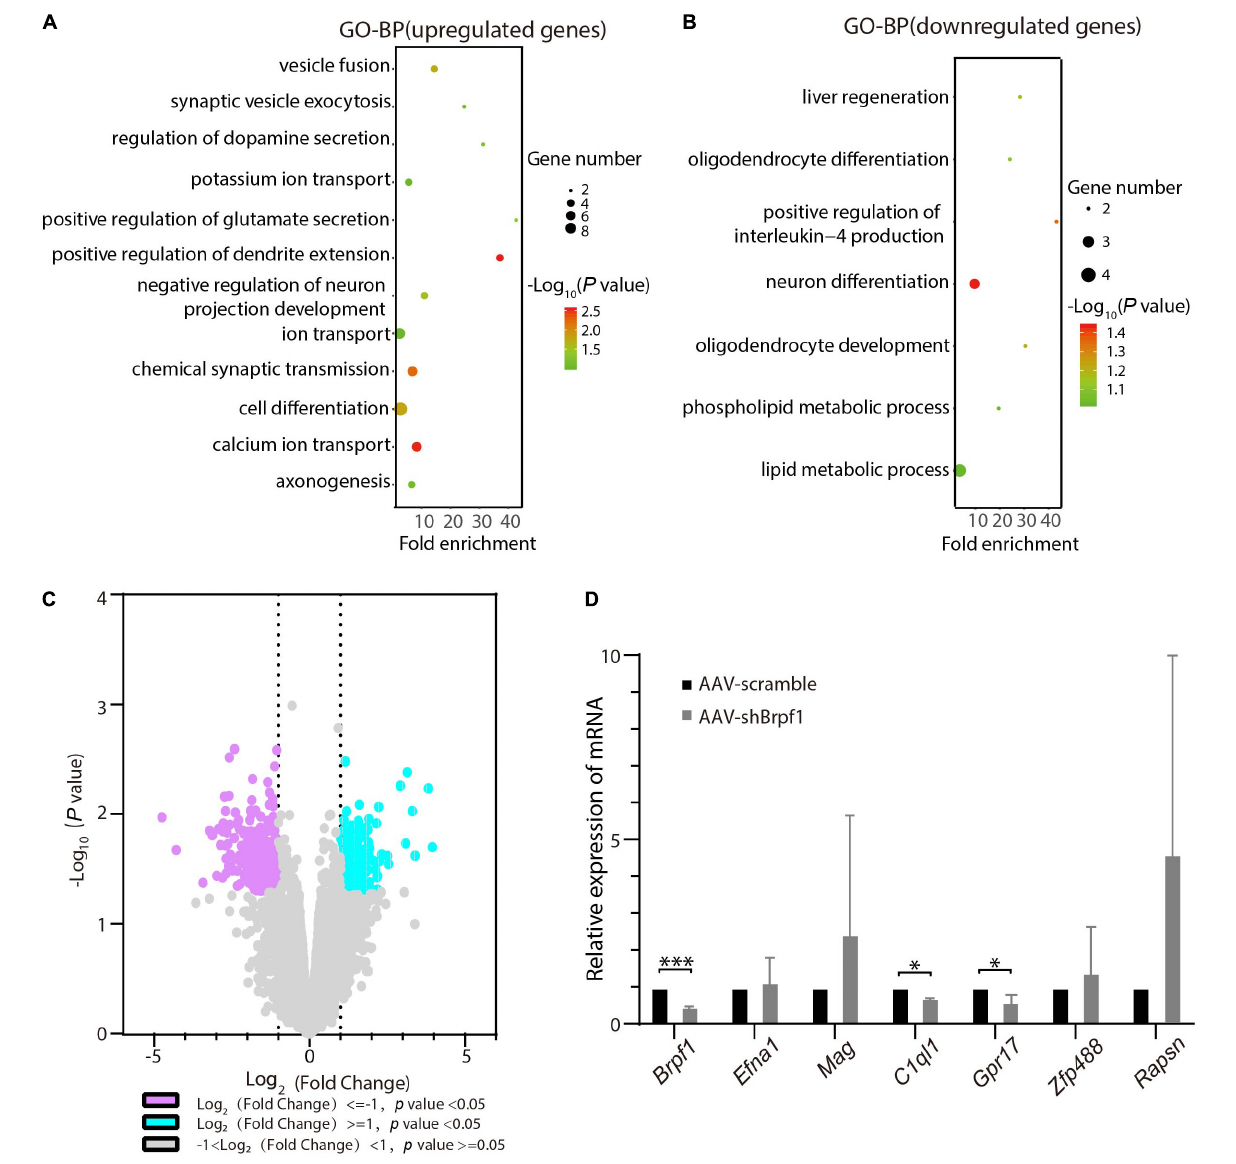
FIGURE 3 | Brpf1 knockdown led to downregulation of C1ql1 and Gpr17. (A,B) Bubble plots represented GO-BP of upregulated genes [log 2 (fold change) ≥ 1 and p < 0.05] and downregulated genes [log 2 (fold change) ≤ –1 and p < 0.05] derived from mRNA-Seq analysis of three pairs of cultured primary hippocampal neurons, respectively. Dot size reflected gene number; color indicated –log 10 P. (C) Volcano plot of DEGs from mRNA-Seq similar to (A,B) . (D) Selected DEGs were validated by RT-qPCR (AAV-scramble group, n = 3 batches; AAV-shBrpf1 group, n = 3 batches). ∗ p < 0.05, ∗∗∗ p <